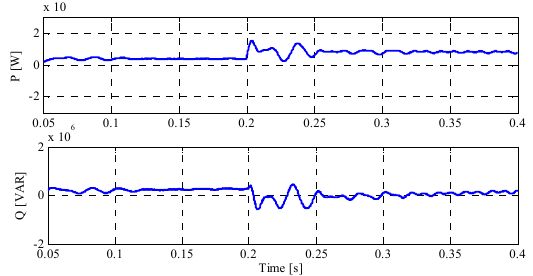
Figure 19. The active and reactive power of MMC with MMC input current variations.